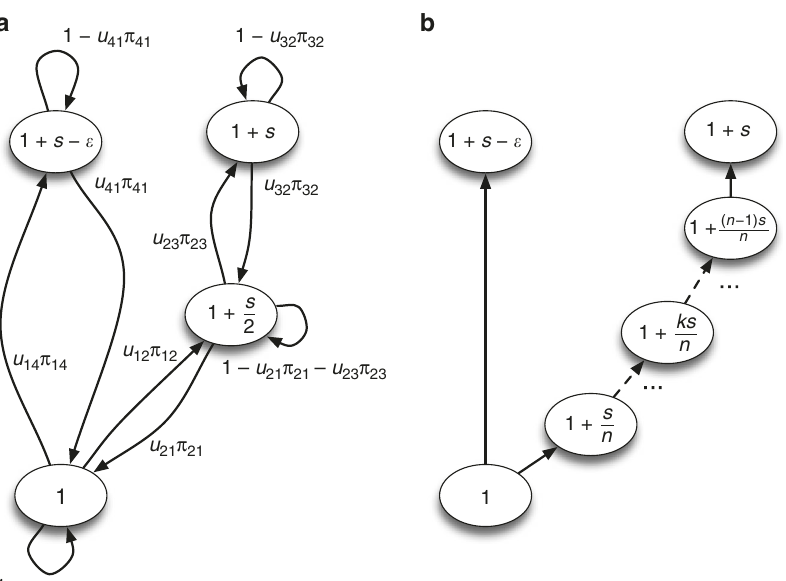
Fig. 2 The fi tness landscapes for the Markov model to test for the evolution of drift robustness. Each circle represents one genotype and is labeled with its fi tness. Each arrow represents the transition between one genotype to another (including the identical genotype) and is labeled with the transition probability. a The fi tness landscape for the minimal model. s represents the selection coef fi cient of the drift-fragile peak and ϵ represents the small fi tness difference between the drift-fragile peak and the drift-robust peak. u ij and π ij represent the mutation rate between genotypes and probability of fi xation from one genotype to another, respectively. b The fi tness landscape for the extended model. Variables as in a . Transition probabilities omitted for clarity